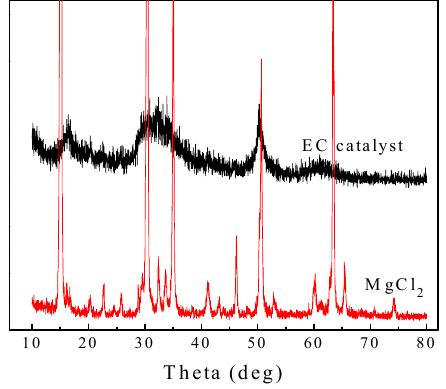
Figure 10. XRD analysis of the MgCl 2 and the catalysts.